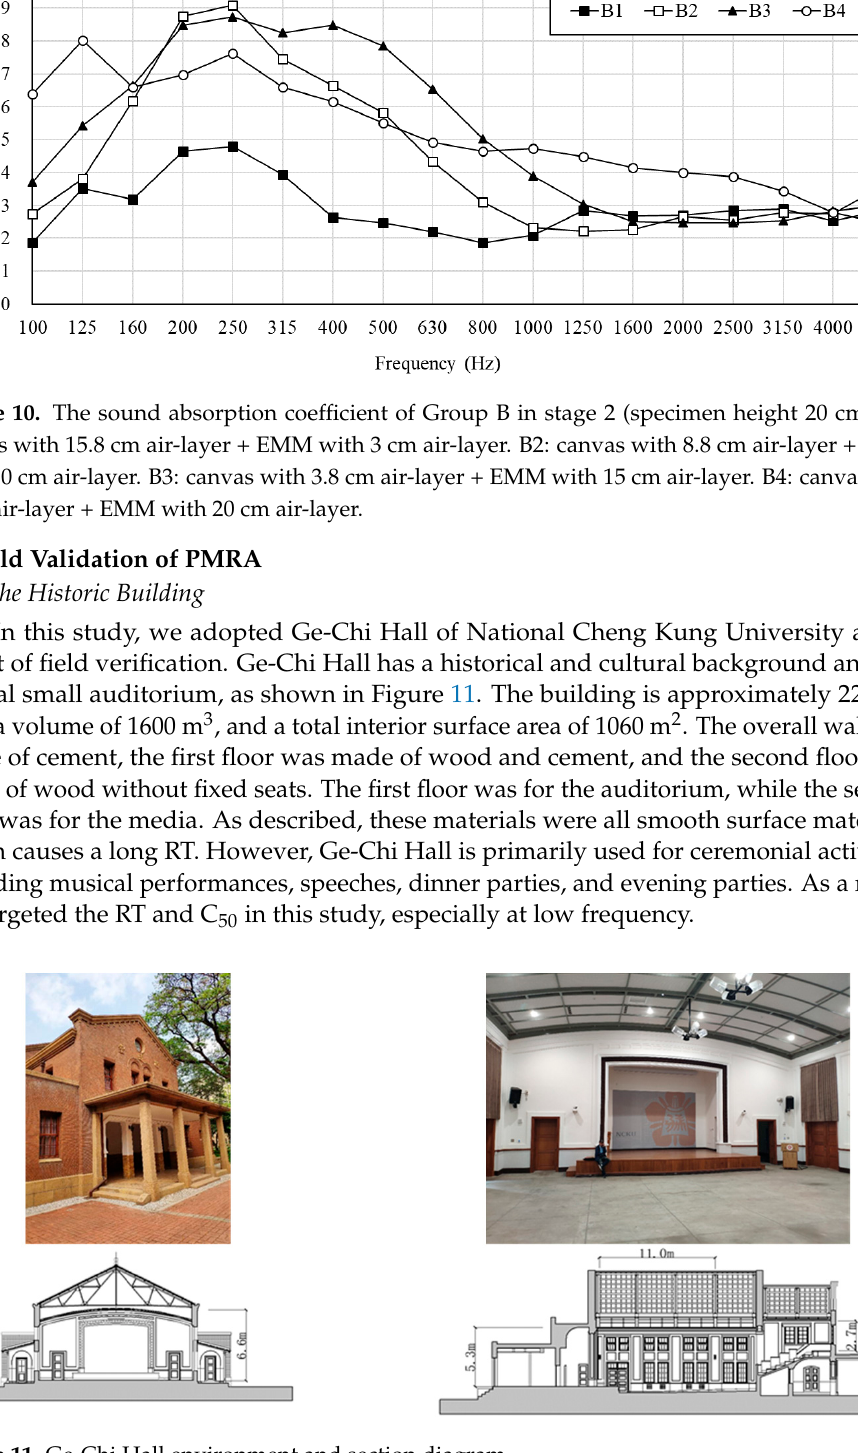
Figure 9. The sound absorption coefficient of Group A in stage 2 (specimen height 10 cm).